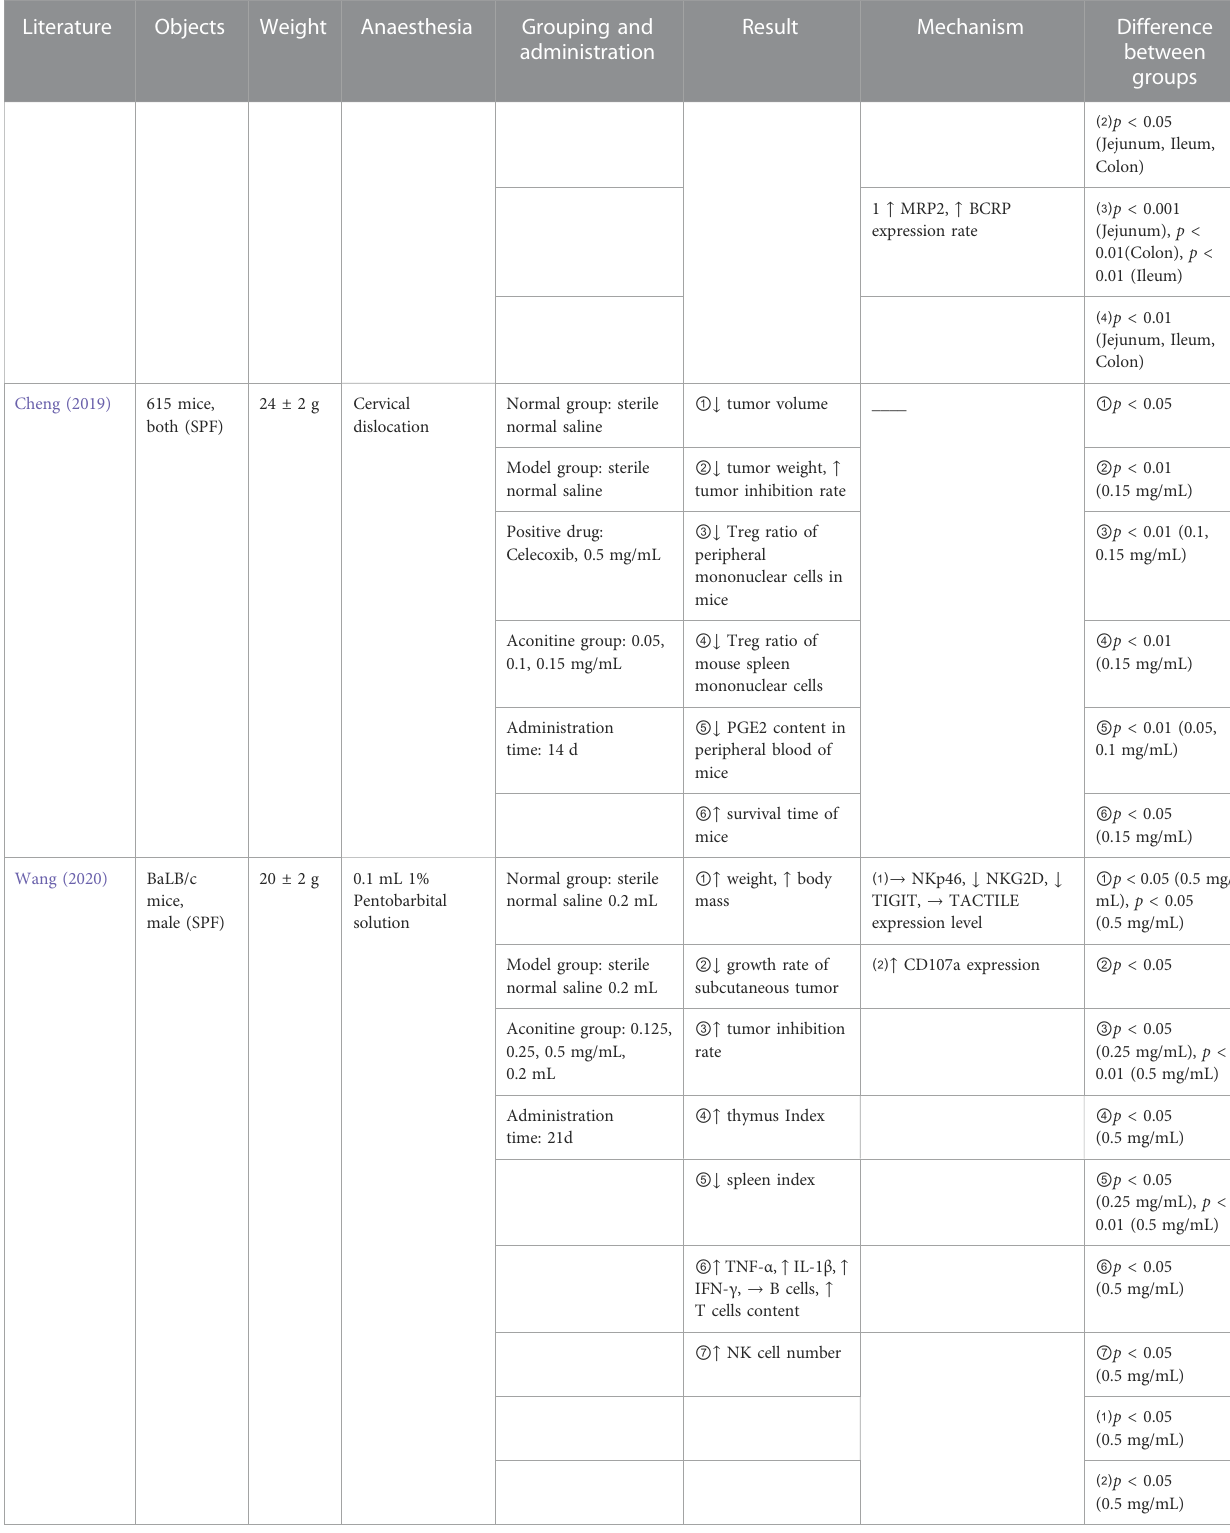
Two studies were analyzed to compare changes in cell proliferation numbers between control and experimental groups. Heterogeneity was observed between trials ( Tau 2 = 0.06, Chi 2 = 166.34, df = 1, I 2 = 99%, p < 0.00001), requiring the use of